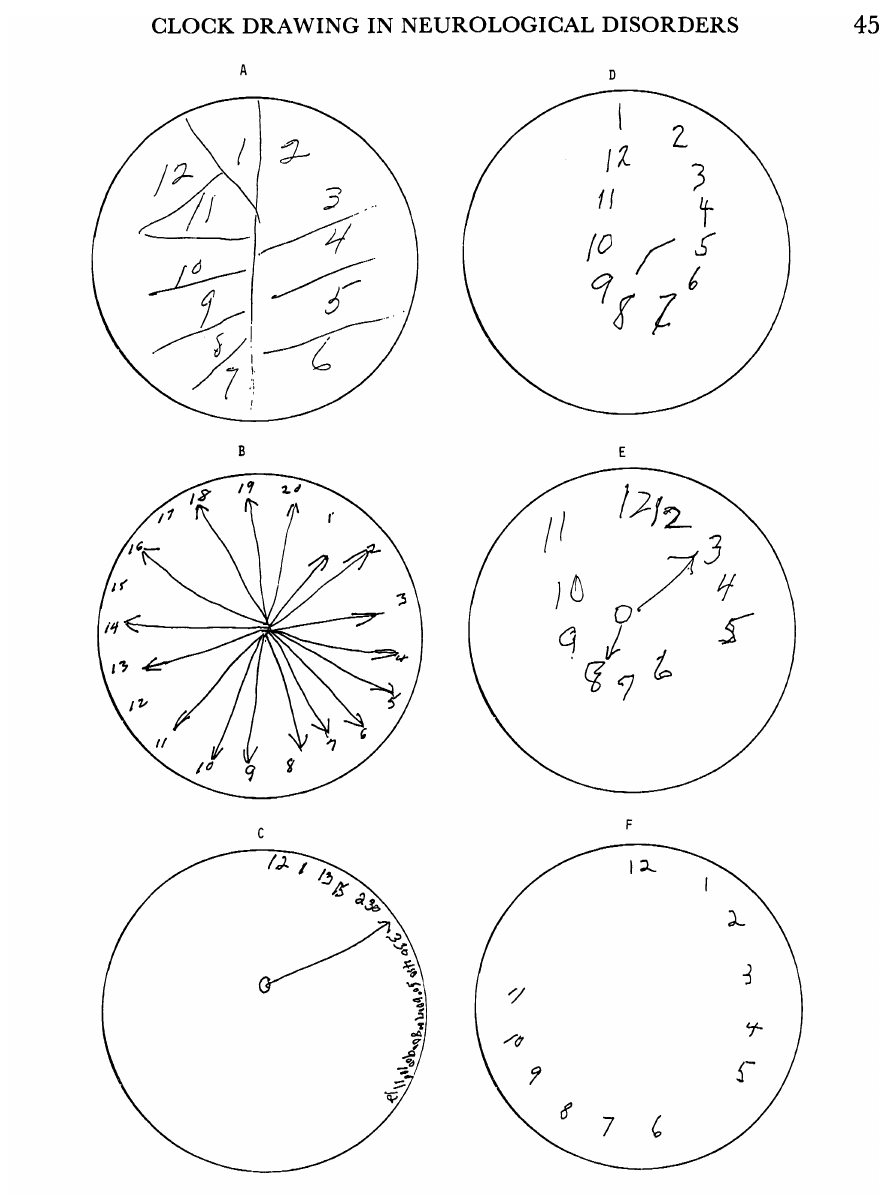
FIG. 1. Clocks drawn by patients with pAD or PD. A. Clock drawn by a 79-year-old woman with pAD. The numbers are not bordering on the perimeter, the symmetry is poor, and stray lines are present. B. Clock drawn by a 67-year-old woman with pAD. Extra numbers and stray lines are present. C. Clock drawn by a 72-year-old man with pAD. The numerical sequence is incorrect, and the symmetry is poor. D. E. Clock drawn by a 74-year-old man with PD. The numbers are grouped in distinct clusters. and between the II and the